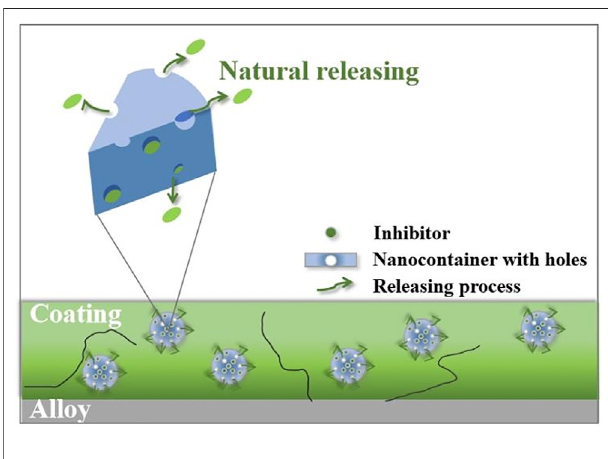
FIGURE 9 | Schematic diagram of natural release method of nanocontainer loaded corrosion